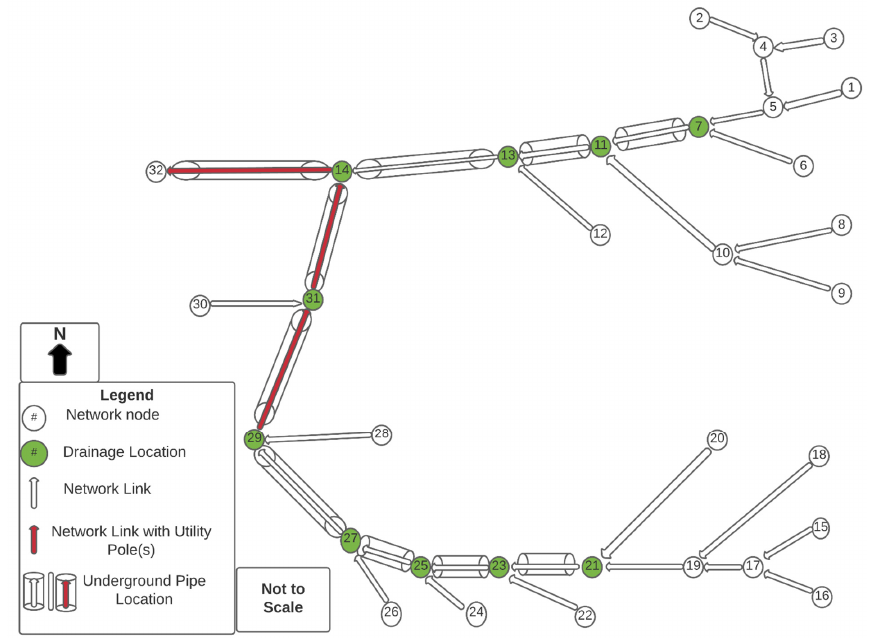
Figure 6. Whittier, NC watershed network schematic for the 100 ‐ year storm. Table 4. Optimized values for Whittier, NC watershed (analysis for 100 ‐ year storm).